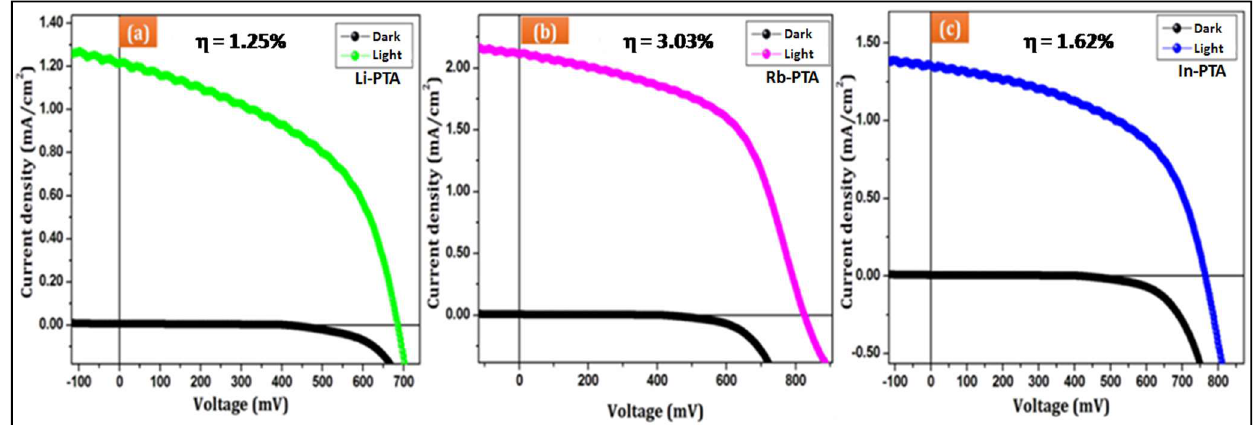
Figure 8. Current density–voltage ( J-V ) characteristics of deposited ( a ) Li−PTA, ( b ) Rb−PTA, and ( c ) In−PTA. From the J-V curves, the fill factor ( FF ) and power conversion efficiency ( η %) of Li + , Rb + , and In 3+ -intercalated PTA films were evaluated using Equations (17) and (18) [45].